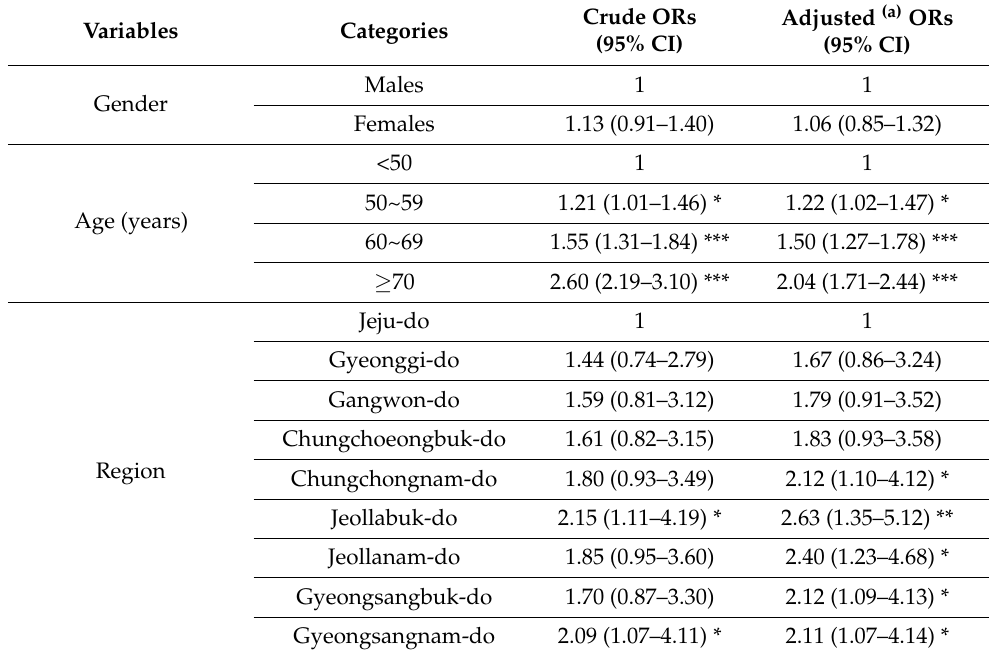
Table 2. Odds ratio (by logistic regression analysis) of the determinants of the occurrence of injuries related to agricultural machinery.